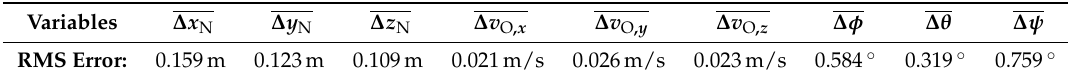
Table 6. The root-mean-square error for estimated